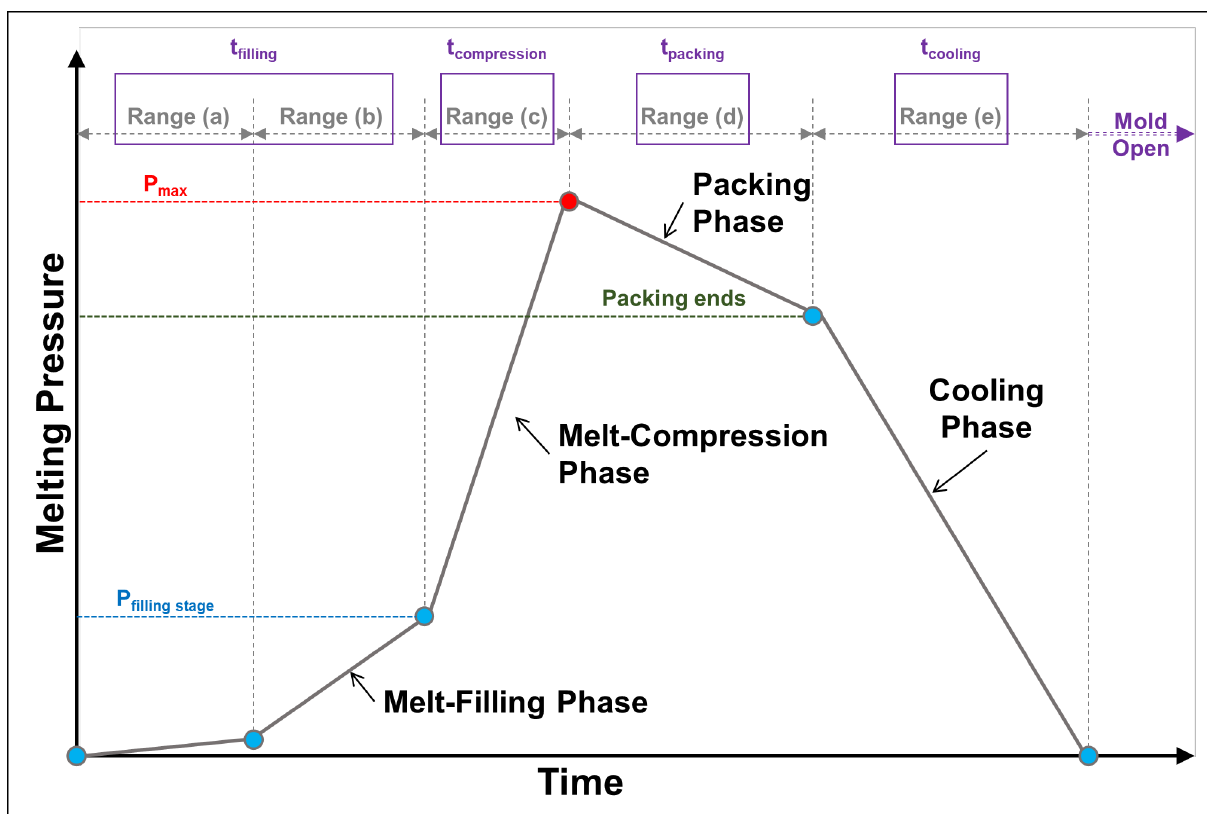
Figure 1. Trend chart of melting pressure for the basic injection process. First, range (a) and range (b) represent the filling stage; range (a) occurs as the melt contacts the pressure sensor and gradually generates and reaches a stable-increase pressure trend; range (b) is the pressure trend when the melt enters the cavity. Range (c) is the value after the melt has completely filled cavity and enters the compression stage; the pressure value of this stage is the maximum value of the filling stage, and it indicates the end of filling and entry into the next stage (range (d)). However, if the pressure at the gate or sprue sufficiently high, the pressure compresses the melt. Thereafter, the melt within the cavity is maintained at an assigned pressure during the packing phase when additional plastic melt can be packed into the cavity to compensate for the plastic shrinkage caused by cooling to maintain a completely filled mold. This process continues until the gate is frozen, as marked at range (d). The final cooling phase comes afterward